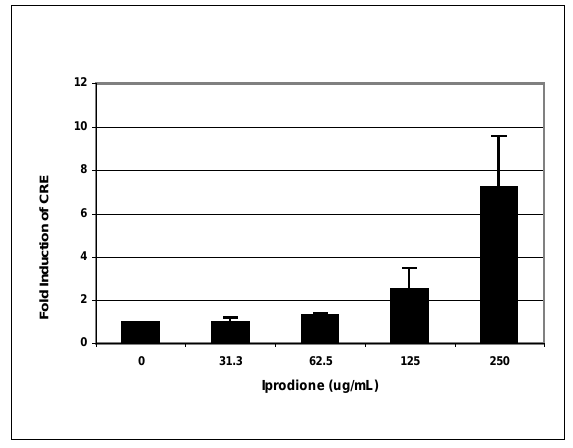
Fig. 6: Fold induction of NF-kBRE in HepG Figure 7 denotes a strong concentration response relationship with regard to induction of the cyclic adenosine monophosphate response (CRE) element within the concentration range of 0 to 250 µg/mL. The induction of this construct indicates that this chemical causes intracellular stress in the transformed hepatocytes Fig. 4: Fold induction of c-fos in HepG cells 2 at 125 and 250 µg/mL. Figure 5 shows the up-regulation of the 70-kDa heat shock protein (HSP70) at the concentration of 250 µg/mL, indicating that iprodione may cause a range of physiological stress conditions at this level of exposure.